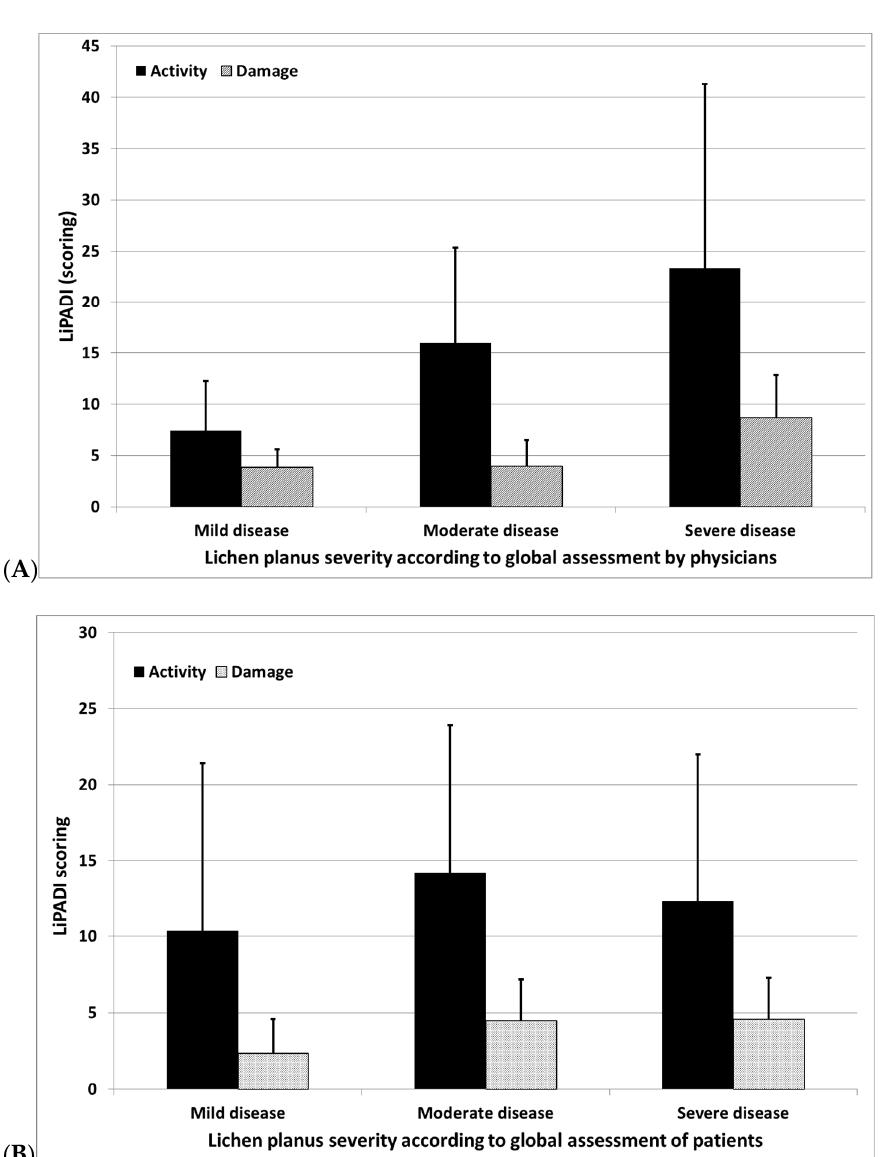
Figure 2. ( A ) Comparison of LiPADI activity and damage scoring between various levels of lichen planus severity assessed by physicians ( p < 0.01 for activity, p = 0.16 for damage). ( B ) Comparison of LiPADI activity and damage scoring between various levels of lichen planus severity assessed by patients ( p = 0.49 for activity, p = 0.22 for damage) (results demonstrates as means ± standard deviations).